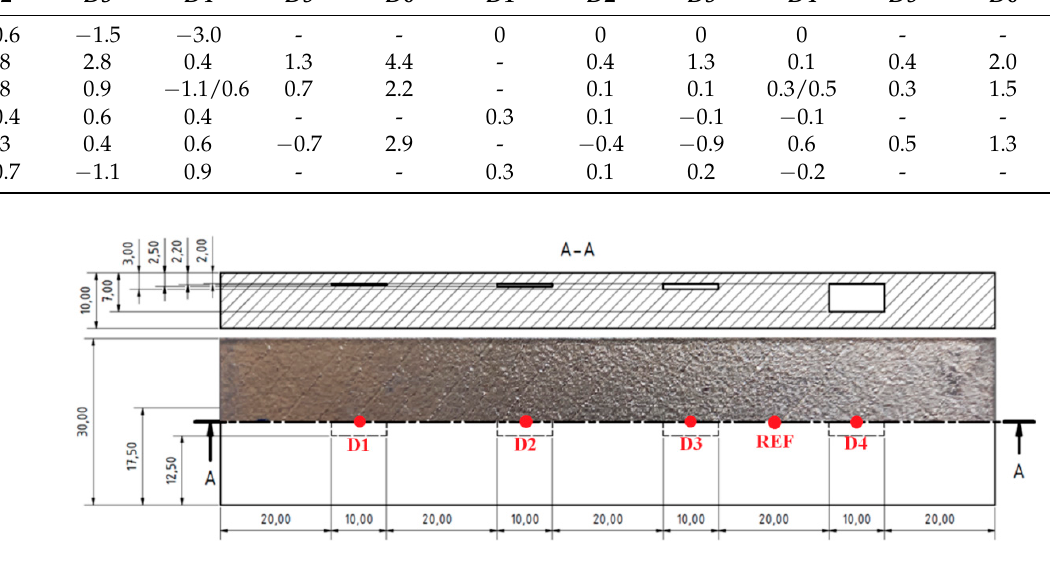
Figure 9. S1 sample.